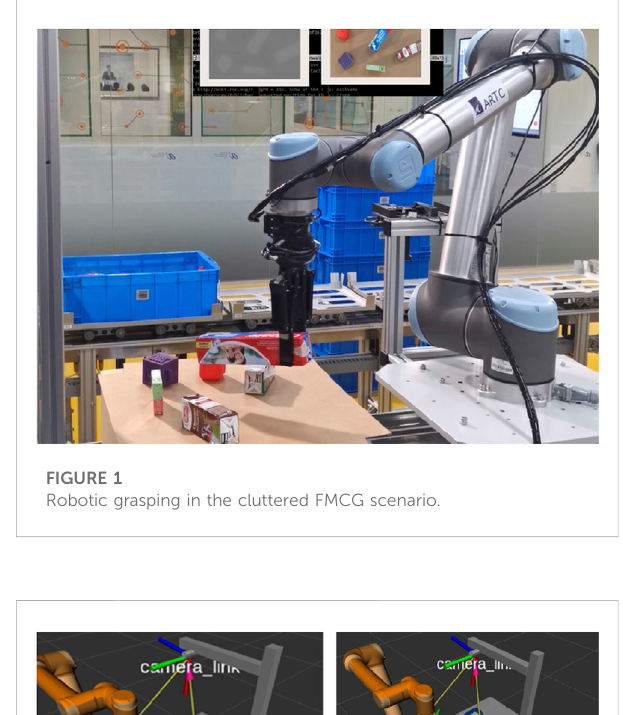
FIGURE 2 (A) Graspingposecandidatesbysampling. (B) Finalgraspingpose with the maximum score.